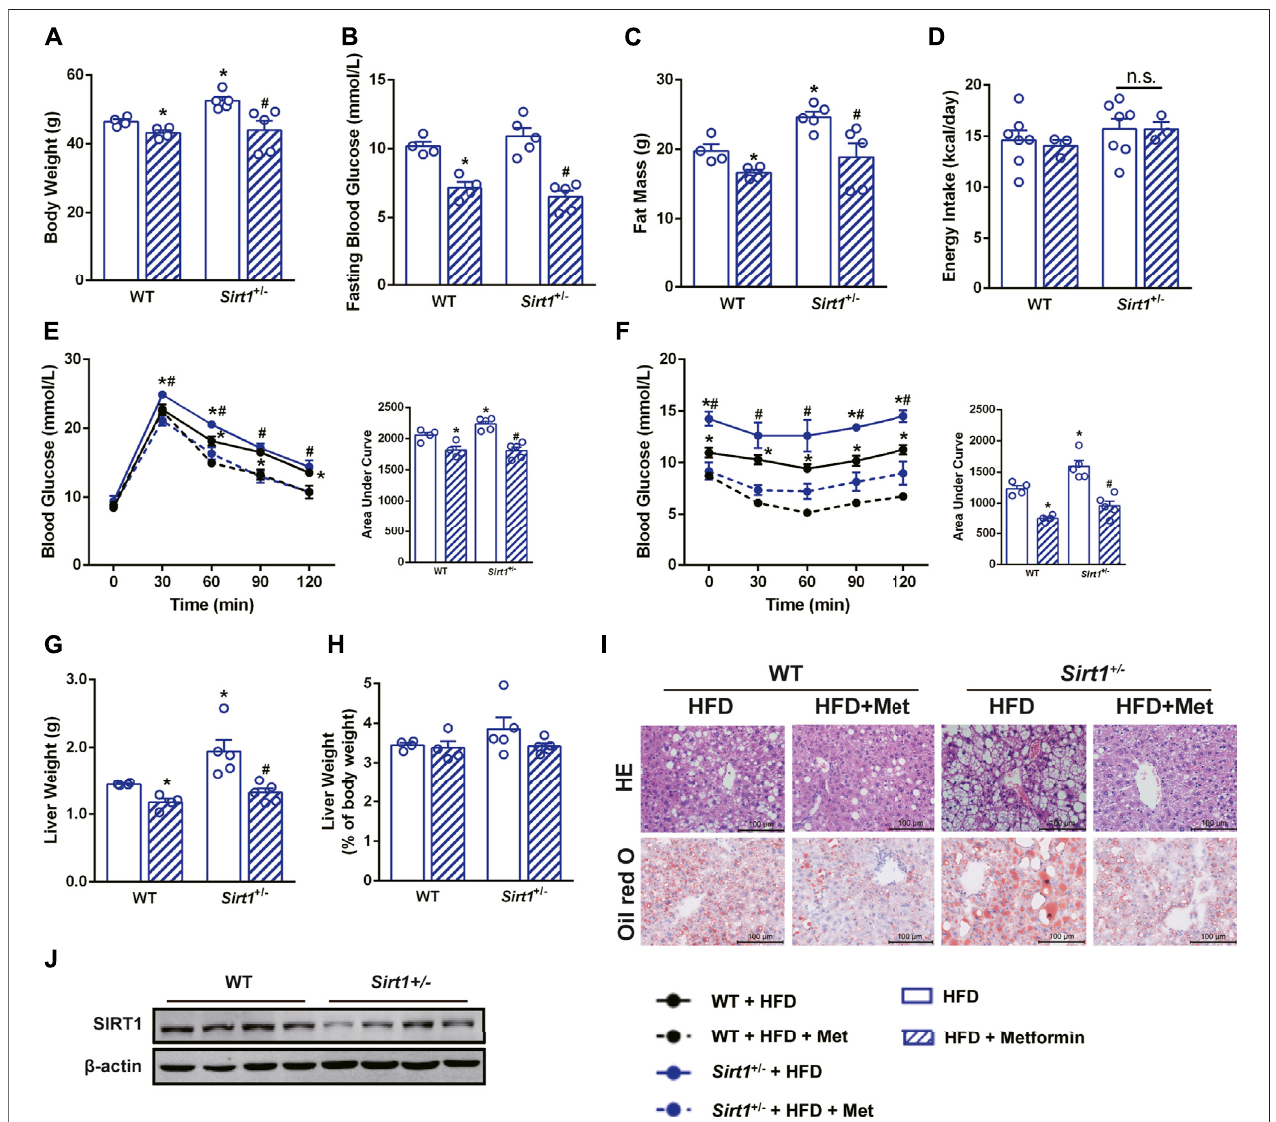
FIGURE 4 | The effect of metformin on reducing body weight and alleviating hepatic steatosis remains in SIRT1 de fi cient mice. SIRT1 de fi ciency did not impair the bene fi cialeffectsofmetforminin (A) bodyweight, (B) fastingbloodglucoseand (C) bodyfatmass( p ＜ 0.05). (D) Energyintakeremainedunaffectedin Sirt1 +/ − mice( p ＞ 0.05). Metformin improved (E) glucose tolerance and (F) insulin sensitivity in Sirt1 +/ − mice. (G) Liver weight, (H) the liver weight to body weight ratio, (I) the H&E staining, andtheOilRedOstainingwith × 400magni fi cationalsoshowedthatmetforminalleviatedhepaticsteatosisin Sirt1 +/ − mice( p ＜ 0.05). (J) SIRT1proteinexpression waslowerinliverof Sirt1 +/ − mice.Dataareshownasmean ± SEM.* p ＜ 0.05WT+HFD+Metforminor Sirt1 +/ − +HFDvs.WT+HFDgroup; # p ＜ 0.05, Sirt1 +/ − +HFD+ Metformin vs. Sirt1 1 +/ − + HFD